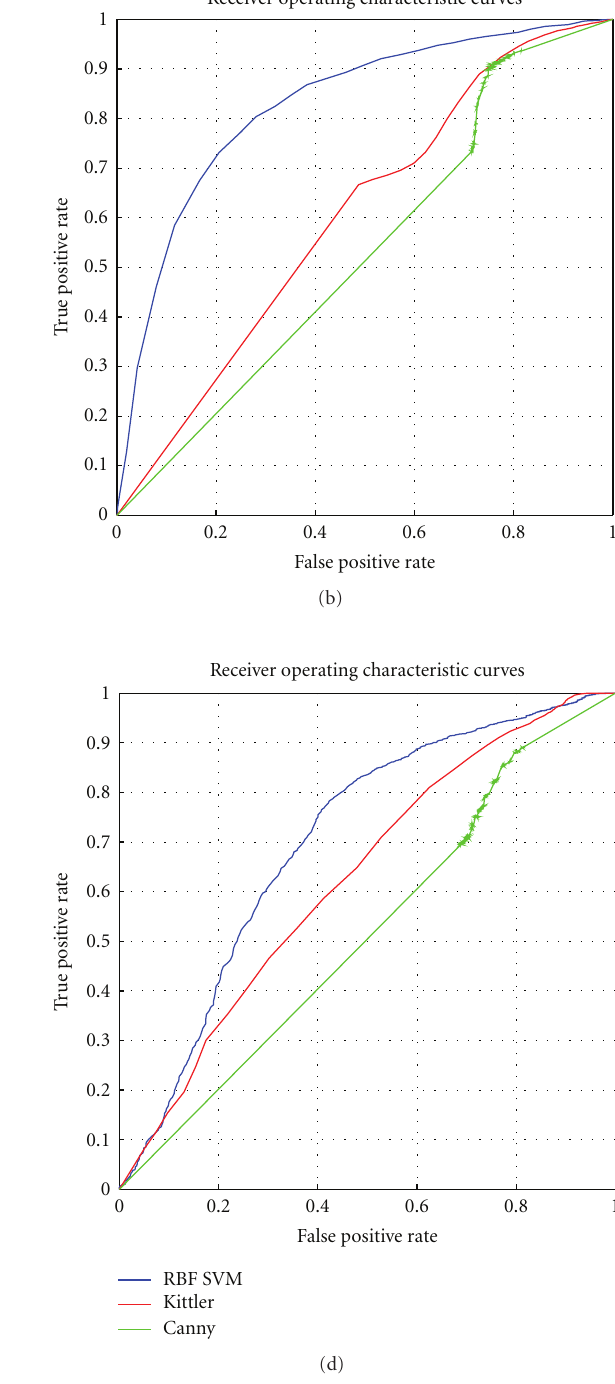
Figure 10: ROC plots for standard Canny and Kittler methods with the SVM (RBF kernel) on four sample images. The performance of the SVM is better, even when applied to the extremely di ffi cult images of the bottom panels.